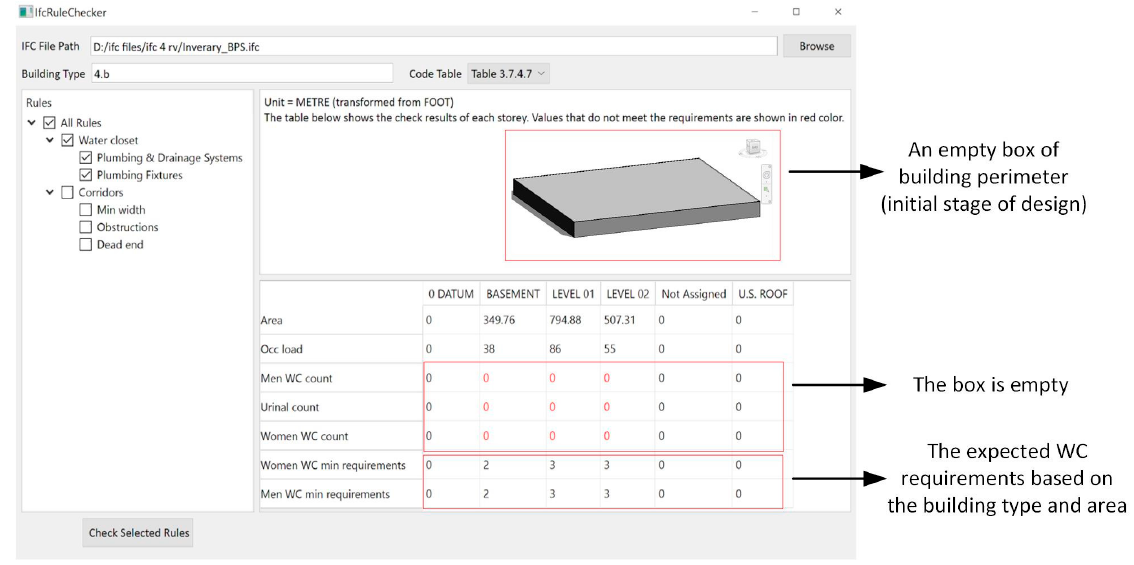
Figure 7. An example of using the system to promote proactive design.